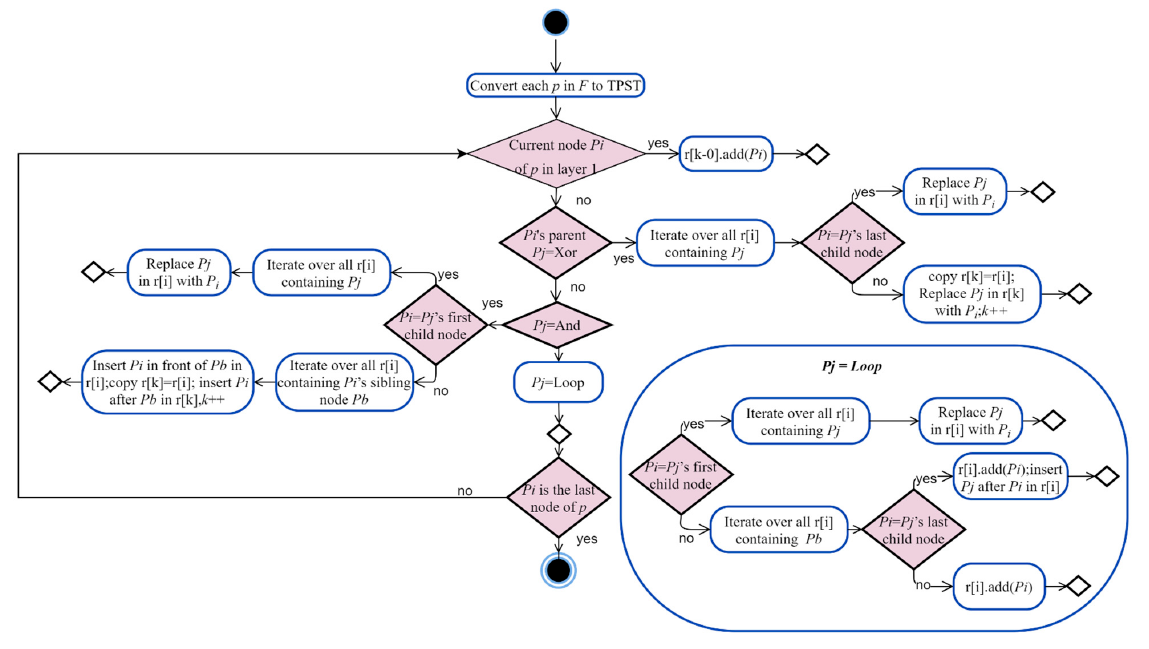
Figure 5. The EPE algorithm framework.